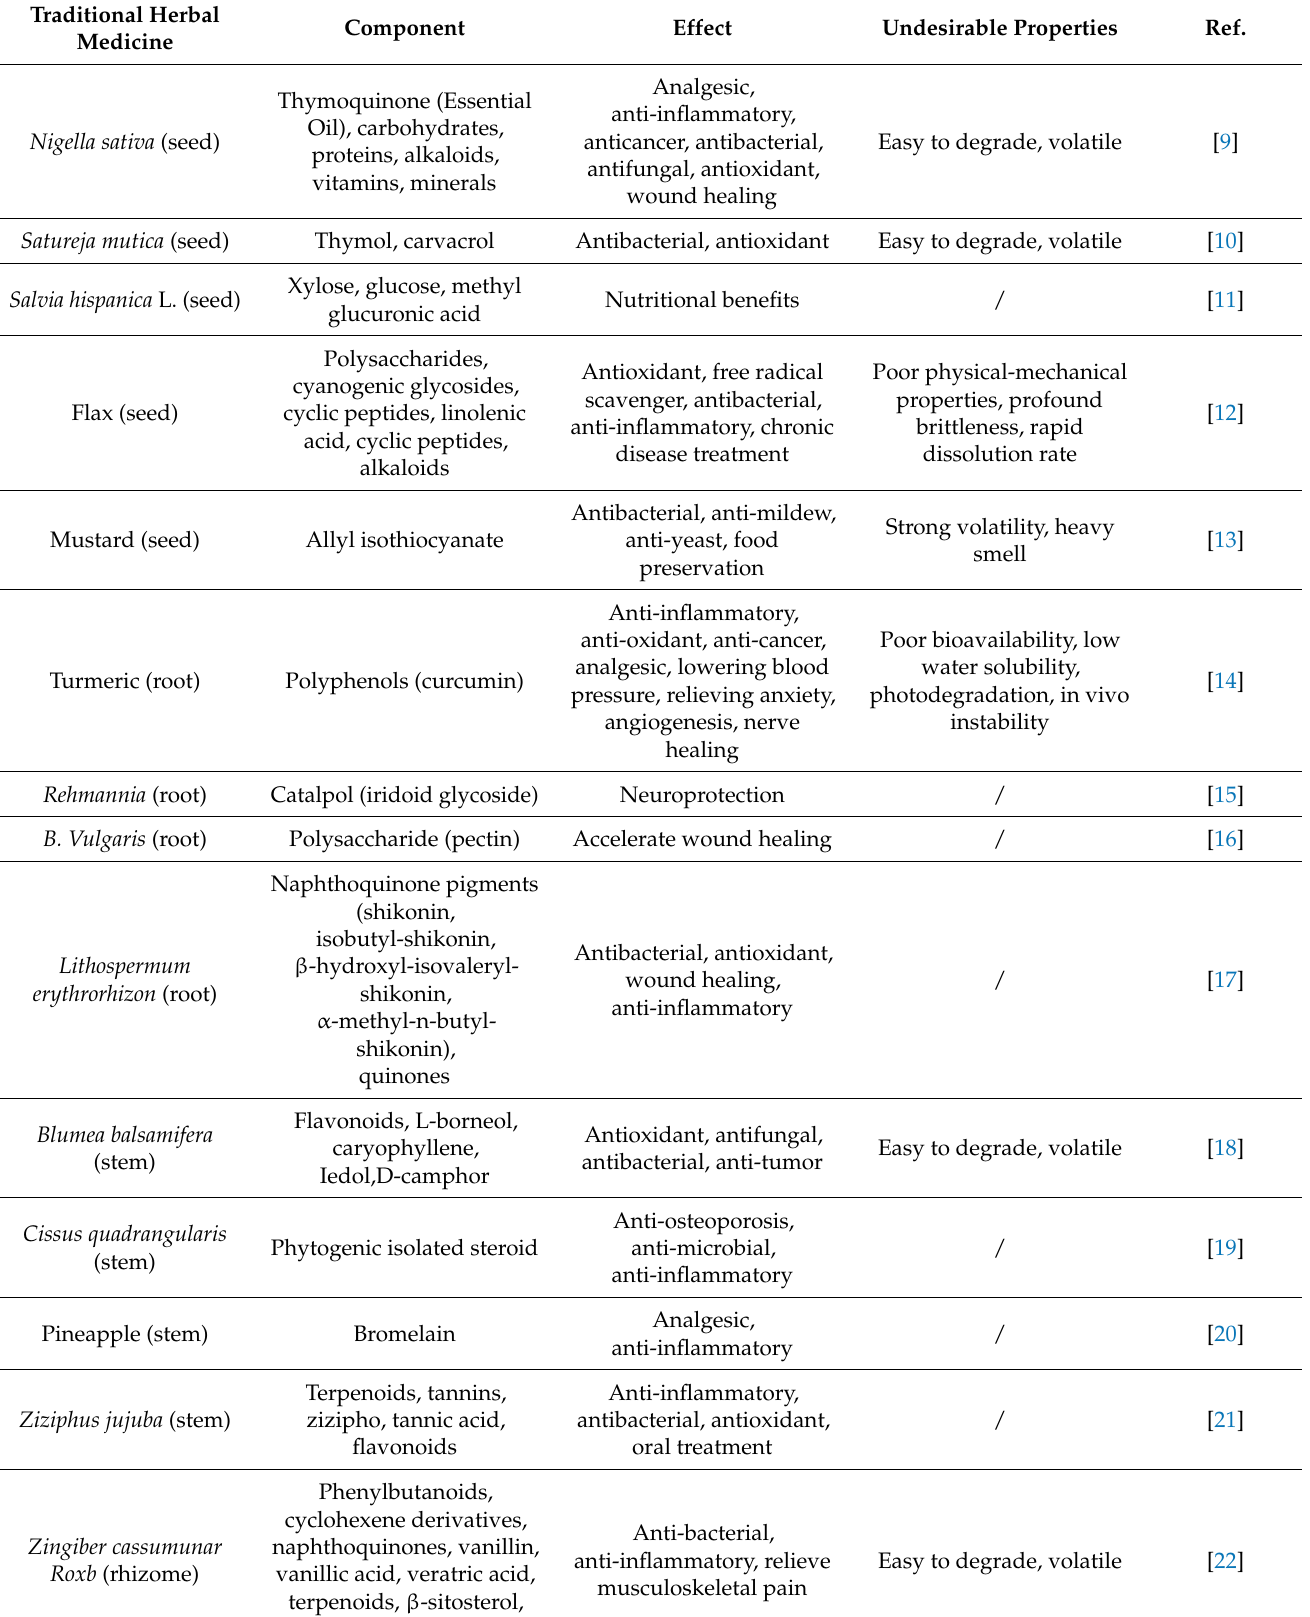
Table 1. Examples of traditional herbal medicine: components, effects and undesirable